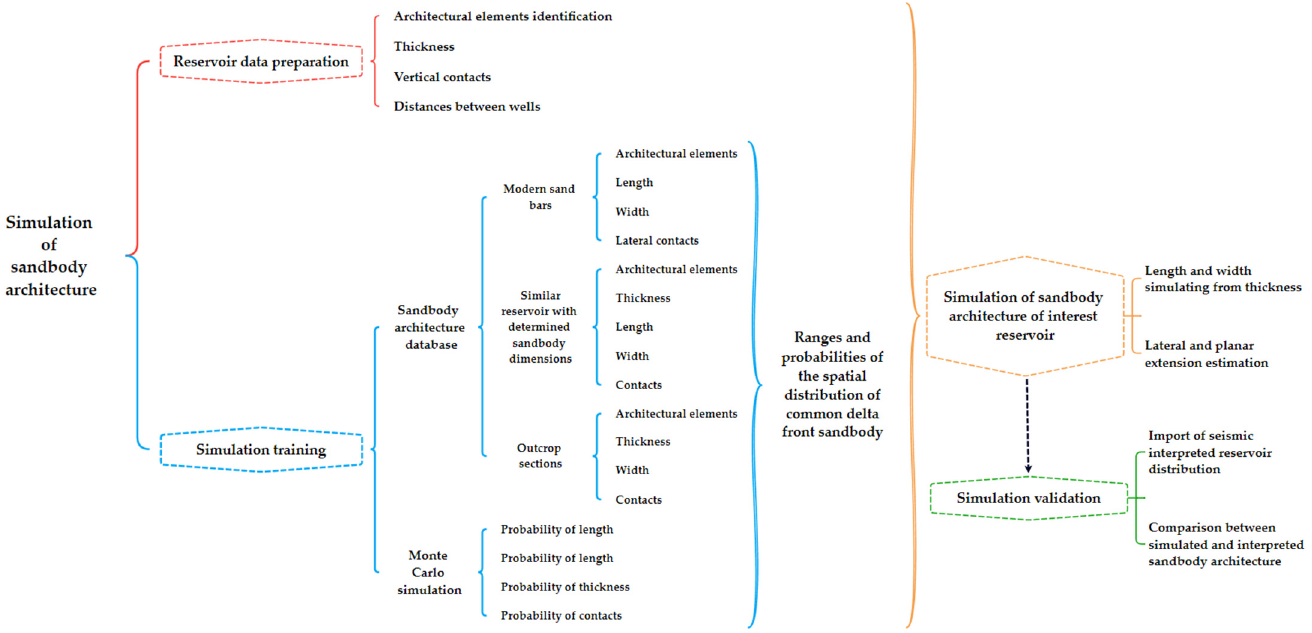
Figure 3. Systematic